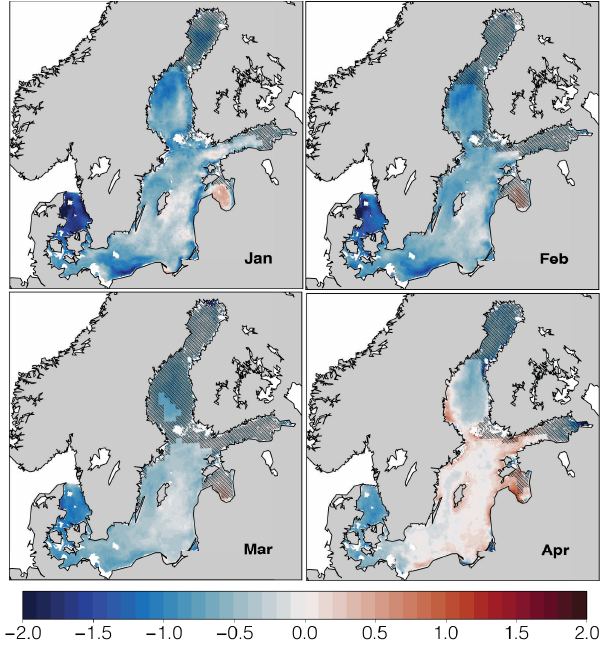
Figure 4. Long-term monthly mean January–April SST bias ( ◦ C) for the period 1990/1991–2005/2006. Positive values mean that NEMO-Nordic is warmer than the BSH satellite observations. Ar- eas where the BASIS/IceMap ice concentration is greater than 50% have been